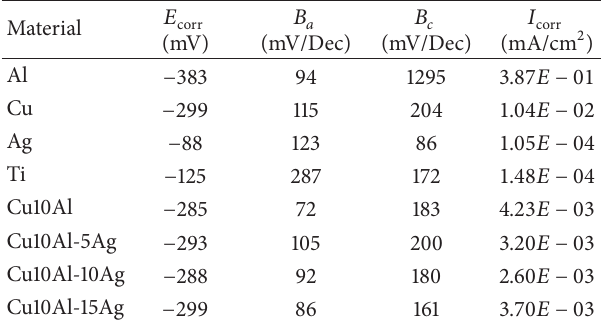
Table 2: Electrochemical parameters of the materials evaluated in artificial saliva at 37 ∘